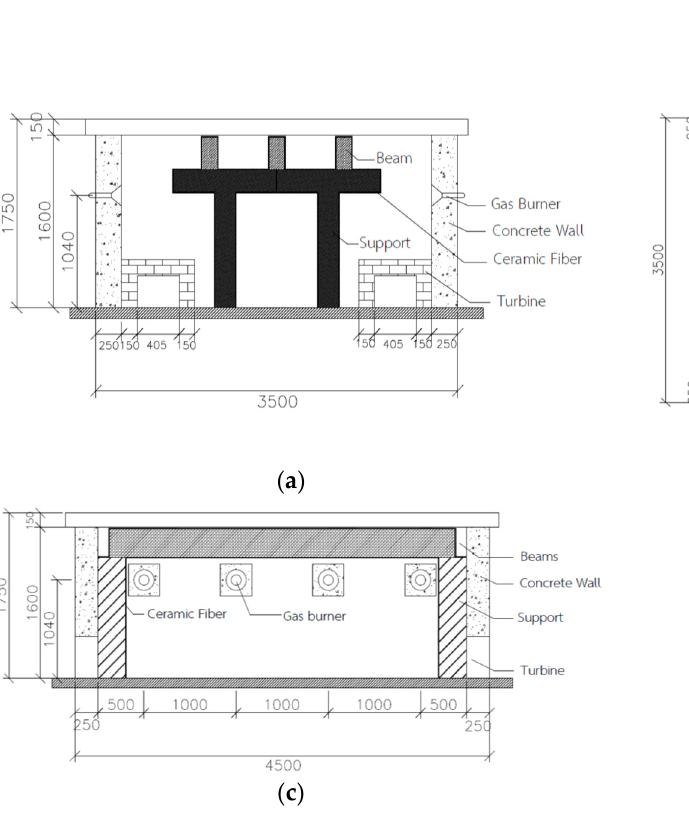
Figure 4. Fire furnace (unit: millimeter); ( a ) front view; ( b ) top view; ( c ) side view.